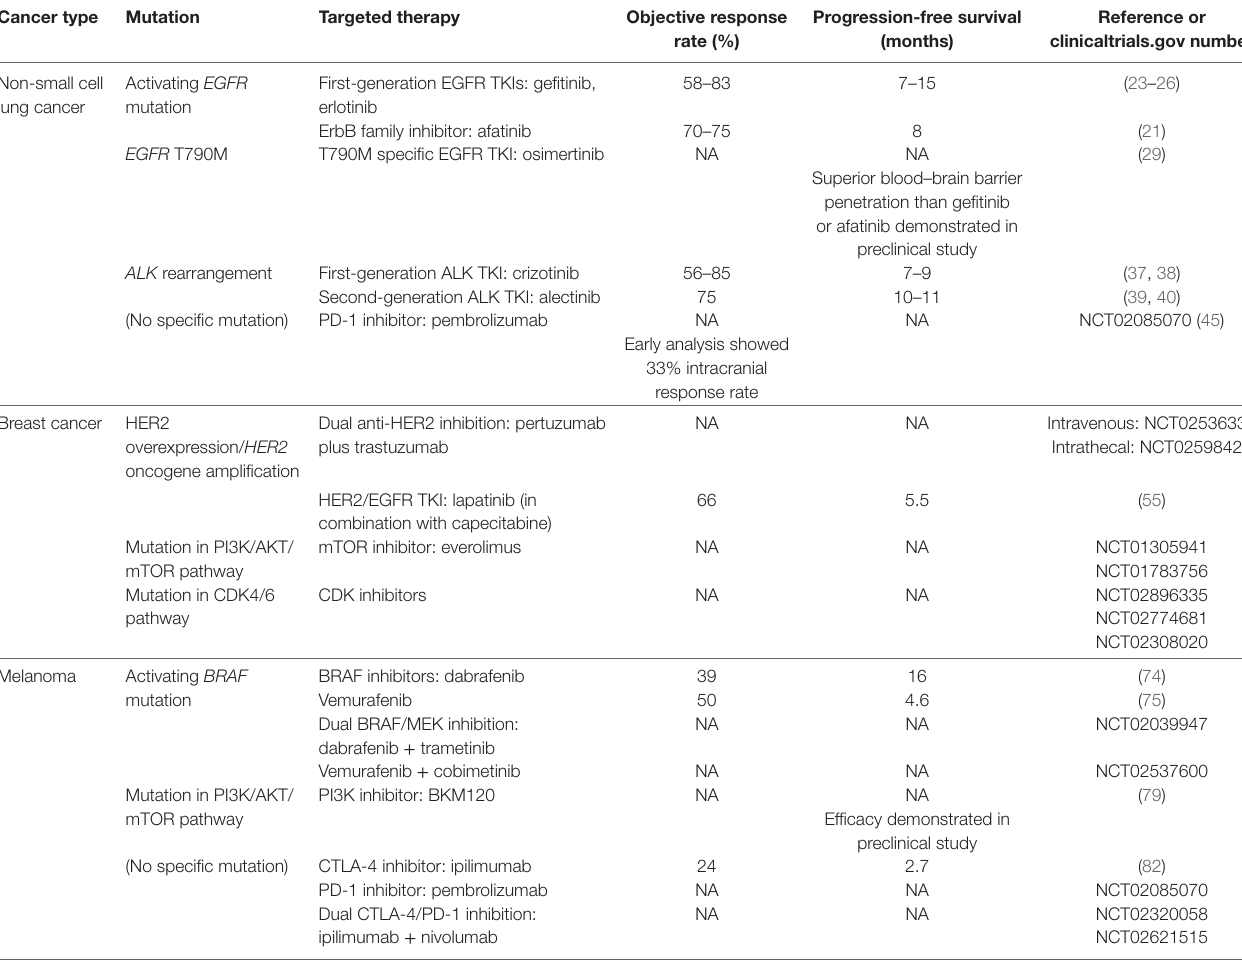
TABLe 1 | Overview of actionable mutations in brain metastases of non-small cell lung cancer, breast cancer and melanoma, and potential targeted